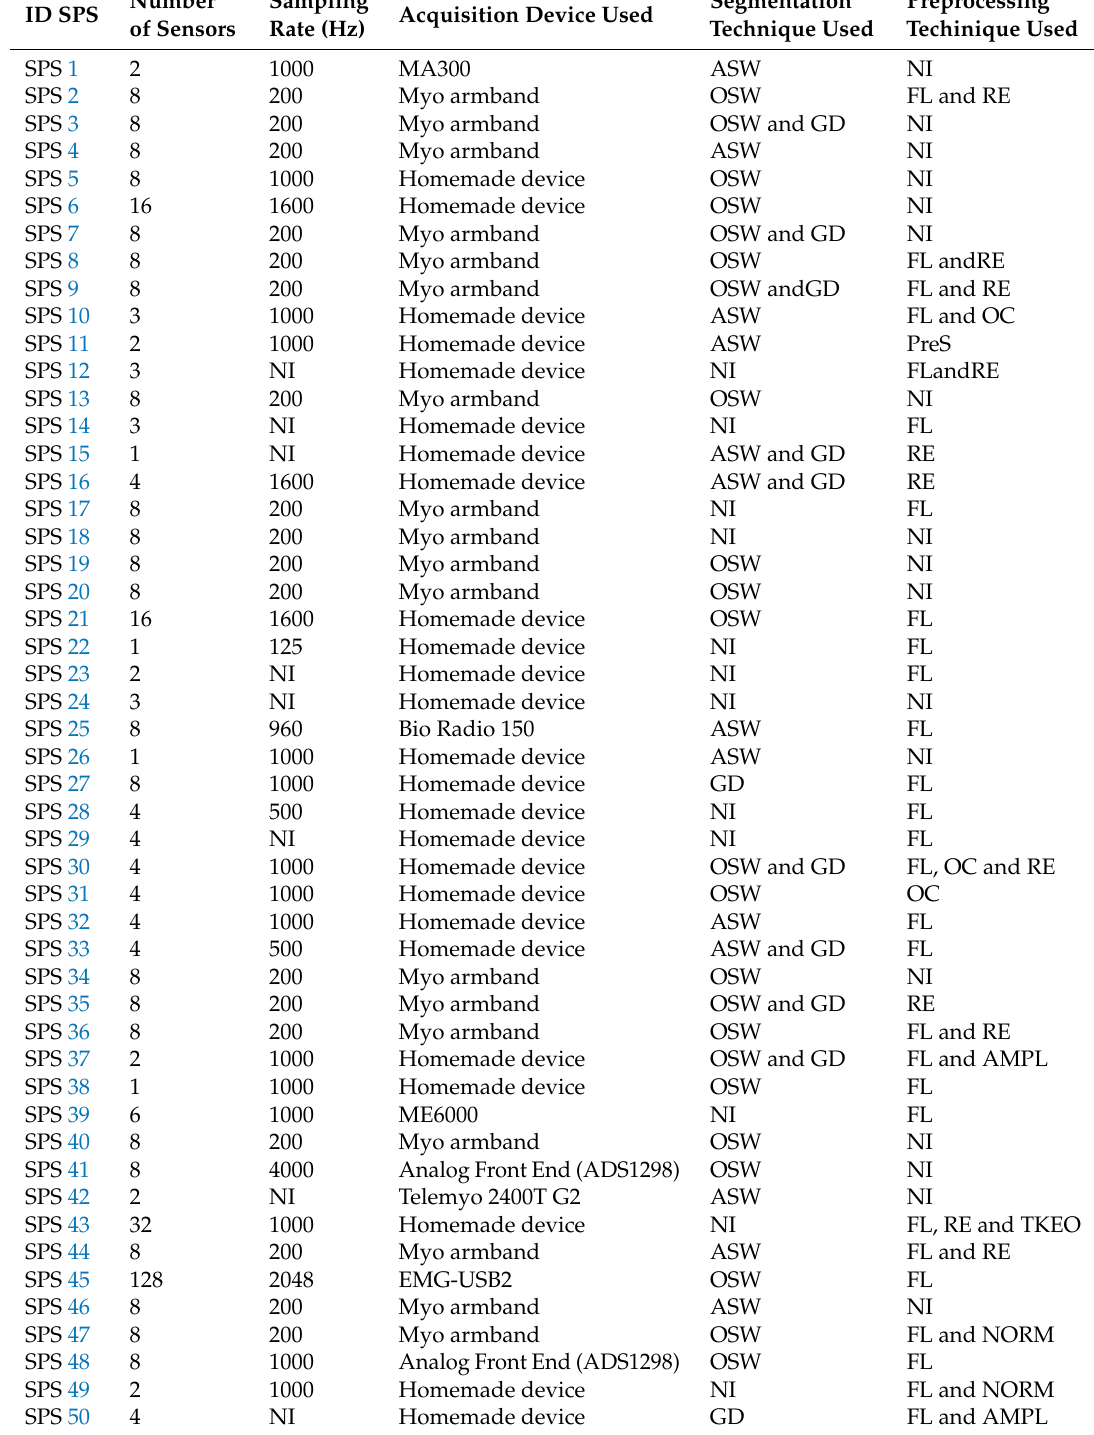
Table 7. The number of sensors, sampling rate, acquisition devices, segmentation techniques, and preprocessing techniques used in the 65 HGR